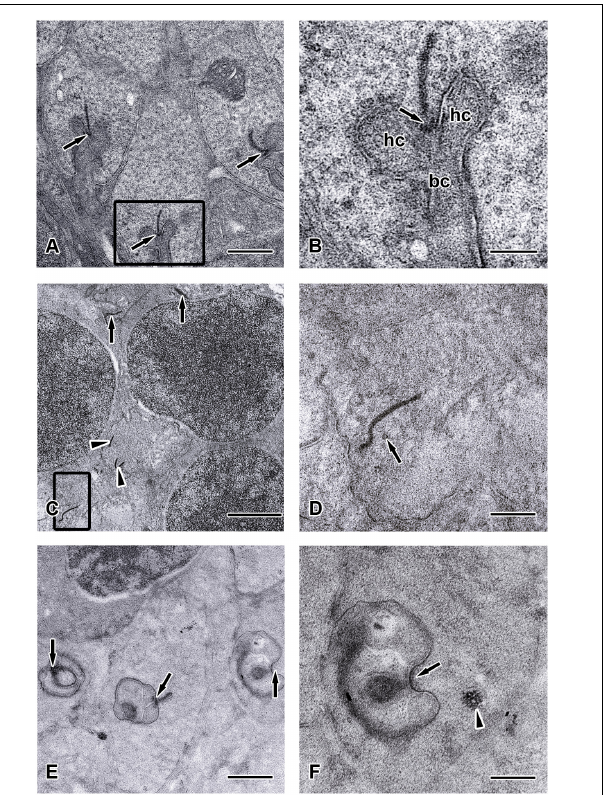
FIGURE 8 | Ultrastructure of the synaptic ribbons in C-Ret lx / lx and Chx10-Cre;C-Ret lx / lx retinas at the age of 12 months. TEM images showed the outer plexiform layer (ONL) of C-Ret lx / lx (A,B) and Chx10-Cre;C-Ret lx / lx (C–F) mice at the age of 12 months. (A) Three typical rod-like synaptic ribbon profiles (arrows) with several mitochondria were observed in the rod spherules of C-Ret lx / lx mice. (B) Higher magnification of the TEM image is shown in the rectangle of (A) . The large presynaptic terminals were filled with numerous synaptic vesicles, and the active zone was characterized by specialized presynaptic densities, the arciform densities (arrows). Opposite to the active zones were the dendritic tips of horizontal cells (hc) and bipolar cells (bc), which contained ionotropic and metabotropic glutamate receptors for signaling. (C–E) Electron micrographs showed different examples of rod terminals and the ultrastructural appearance of the ribbon synaptic complex in the Chx10-Cre;C-Ret lx / lx retina. (C) Some synaptic ribbons (arrows) were found to be mislocalized between cell nuclei in ONL, which were supposed to be found in outer plexiform layer. All other synaptic ribbons were found floating in the cytoplasm (arrowheads) and did not associate with an arciform density nor with the presynaptic membrane. (D) Higher magnification of the TEM images is shown in the rectangle of (C) . Orphan presynaptic density surrounded by synaptic vesicles (arrow) and irregularly shaped floating ribbons were shown in Chx10-Cre;C-Ret lx / lx retinae. (E) Three ultrastructural appearance of the ribbon synaptic complexes (arrows) of photoreceptor terminals were shown. (F) Higher magnification of the TEM images, shown in the rectangles of (E) , displayed an abnormal terminal with postsynaptic elements but without presynaptic ribbon (arrow). Although synaptic vesicles could still be observed, they seemed to be aggregated (arrowhead) rather than in their typical, individual form. Scale bars: (A,E) , 1 µ m; (B,D,F) , 300 nm; (C) , 2 µ